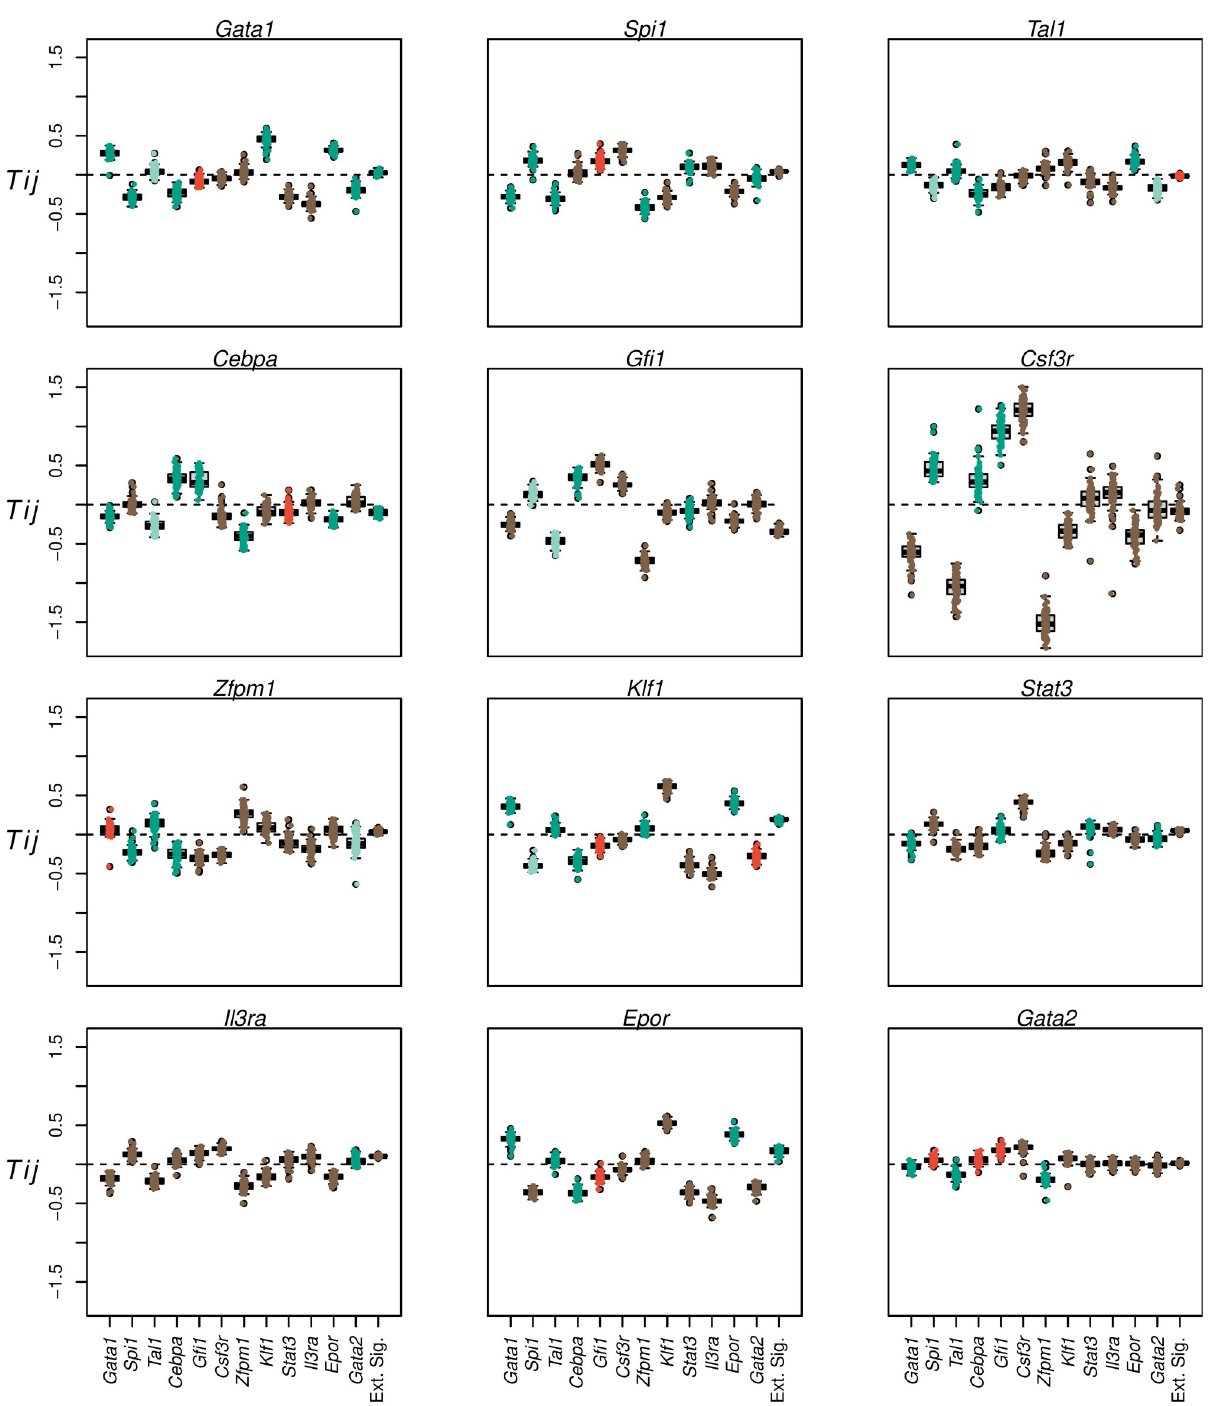
Fig 4. Inferred genetic architecture. The distribution of each genetic interconnectivity parameter ( T ) over the ensemble of 71 models is shown as a ij box plot. The distribution of the each regulatory parameter representing the influence of cytokine conditions ( b i ) is shown as a box plot (“Ext. Sig.”). In the box plots, the box lines are the first quartile, median, and third quartile. The whiskers extend to the most extreme values lying within 1.5 times the interquartile range. Individual parameter values inferred by the models are shown as circles overlaid on the box plots. Each panel shows the regulation of a particular target. Positive and negative values of T ij indicate activation and repression respectively. Positive values of b i indicate activation by Epo and repression by GCSF while negative values indicate activation by GCSF and repression by Epo. Activation is inferred if the first quartile of the distribution is positive, while repression is inferred if the third quartile is negative. The type of regulation is considered to be poorly constrained when